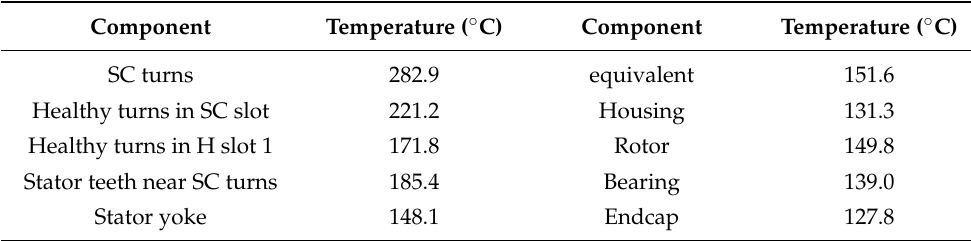
Table 5. Temperature under inter-turn SC faults.